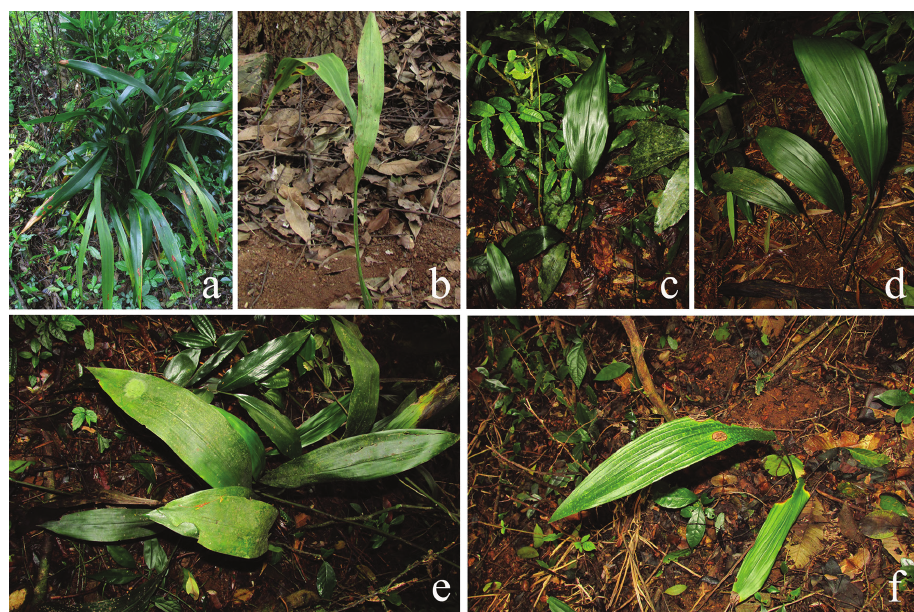
Figure 7. Leaf morphology of diploid plants of Aspidistra subrotata from Mt. Daqing population. a–c leaves with smooth face. a. sublinear leaves b lanceolate leaves c ovate–lanceolate leaves d, e ovate– lanceolate leaves with inconspicuously raised secondary veins f lanceolate leaves with blotches and raised secondary veins.